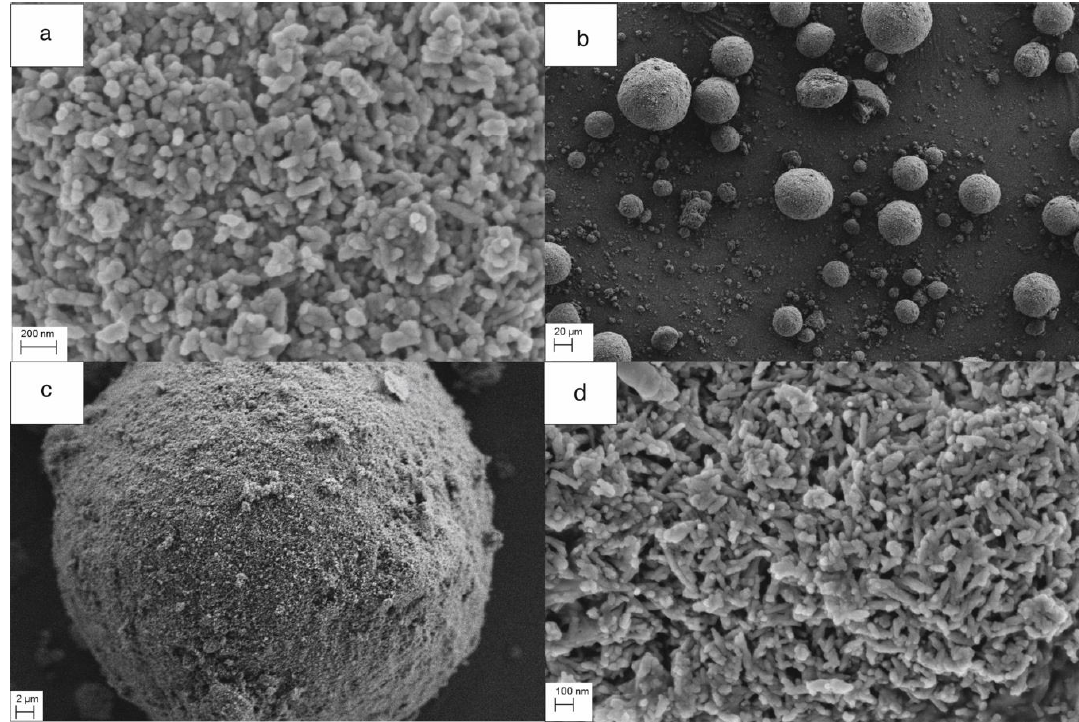
Figure 3. ( a – d ) The morphology of the HAP NPs and composite granules. ( a ) shows the structure in HAP NPs at the magnification of 100,000 × , ( b – d ) composite granules of HAP NPs-PLA at the magnification of 500 × , 5000 × and 100,000 ×.